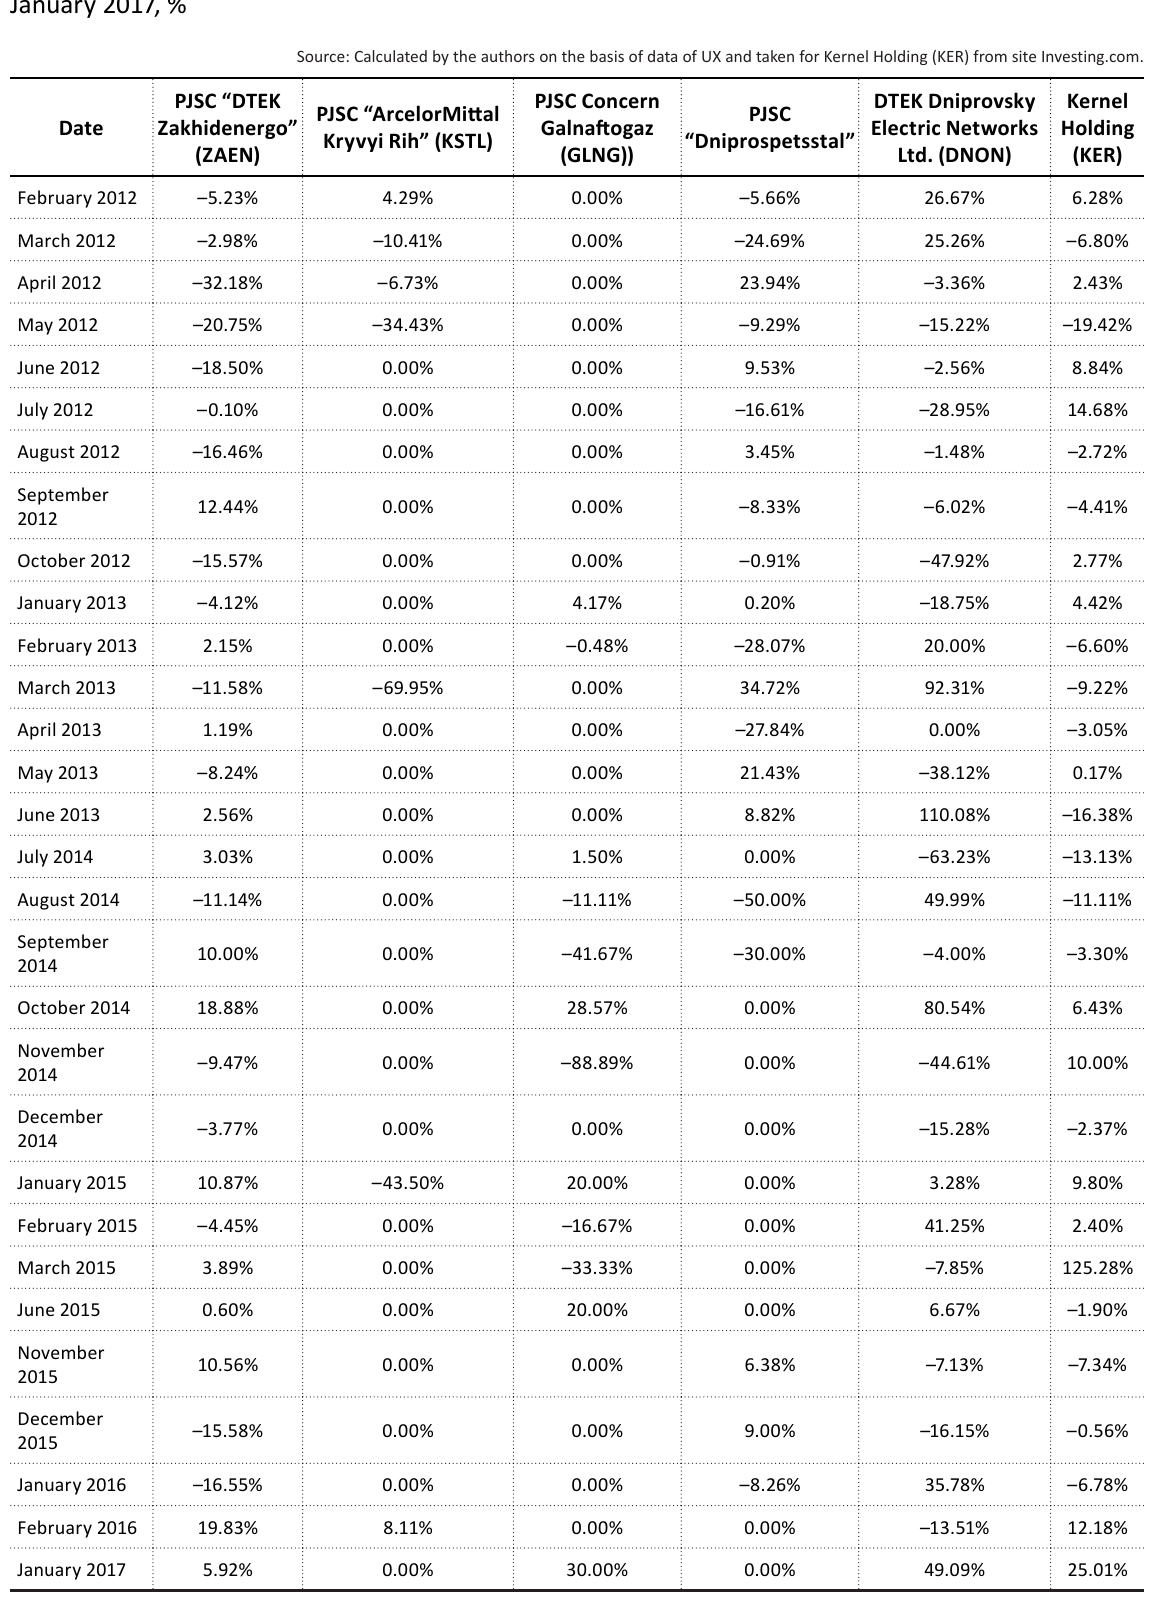
Table A1. The return of shares of companies with CSR strategies per month from February 2012